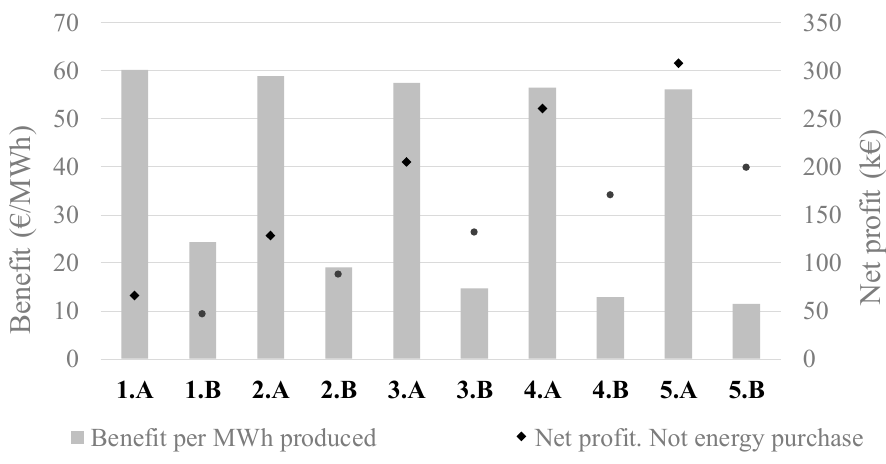
Figure 8. Technical performance of the proposed CHEST system for different case scenarios.